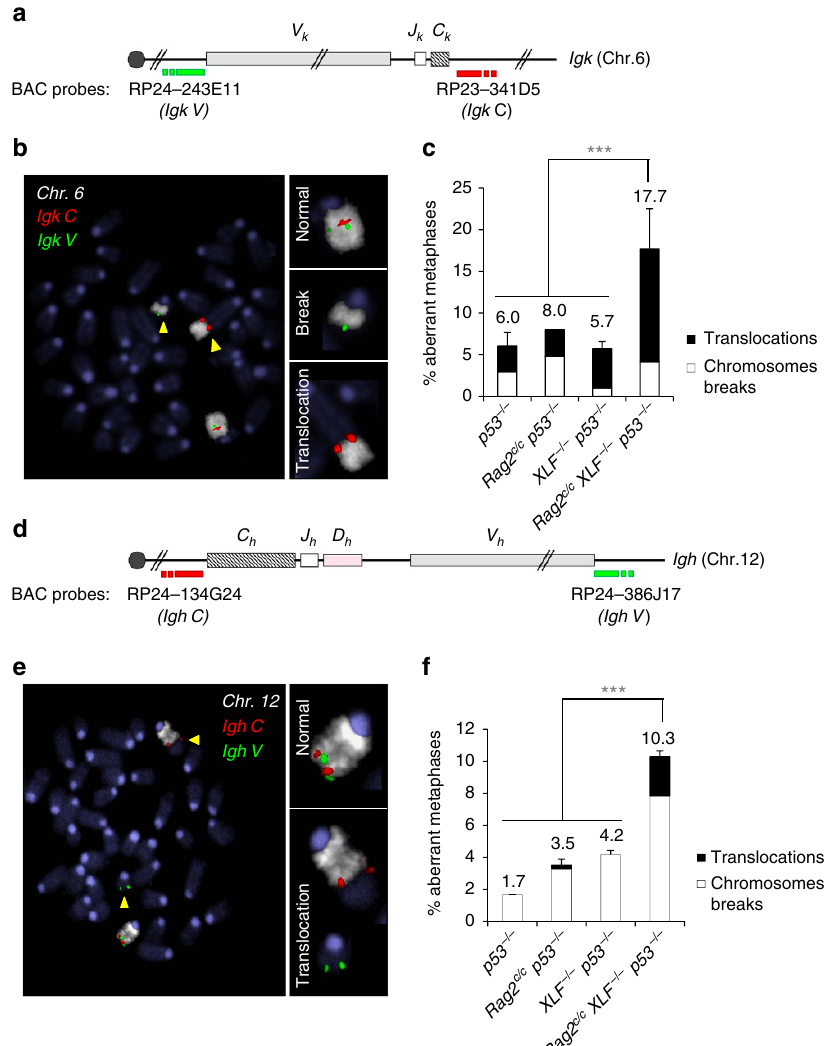
Figure 6 | Aberrant V(D)J recombination leads to genomic instability in Rag2 c/c XLF (cid:2) / (cid:2) p53 (cid:2) / (cid:2) B cells. ( a – c ) Genomic instability at the Igk locus in v-abl pro-B cell lines. ( a ) Schematic representation of the Igk locus, with positions of the BACs used for generation of DNA FISH probes indicated. ( b ) Representative metaphase from Rag2 c/c XLF (cid:2) / (cid:2) p53 (cid:2) / (cid:2) v-abl pro-B cell lines using the Igk C BAC probe (red) combined with Igk V BAC probe (green) and chromosome 6 paint (white). Yellow arrowheads point to broken or translocated chromosome 6. ( c ) Percentage of aberrant metaphases from v-abl pro-B cell lines of the indicated genotype harbouring chromosomes breaks (white) or translocations (black) involving the Igk locus. Histograms represent means þ s.e.m. of two to three independent cell lines (see also Supplementary Table 3). *** P o 0.001. ( d – f ) Genomic instability at the Igh locus in primary pro-B cells. ( d ) Schematic representation of the Igh locus, with positions of the BACs used for generation of DNA FISH probes indicated. ( e ) Representative metaphase from Rag2 c/c XLF (cid:2) / (cid:2) p53 (cid:2) / (cid:2) pro-B cells using the Igh C BAC probe (red) combined with Igh V BAC probe (green) and chromosome 12 paint (white). Yellow arrowheads point to broken or translocated chromosome 12. ( f ) Percentage of aberrant metaphases from pro-B cells of the indicated genotype harbouring chromosomes breaks (white) or translocations (black) involving the Igh locus. Histograms represent means ± s.e.m. of at least three independent experiments (See also Supplementary Table 4). *** P o